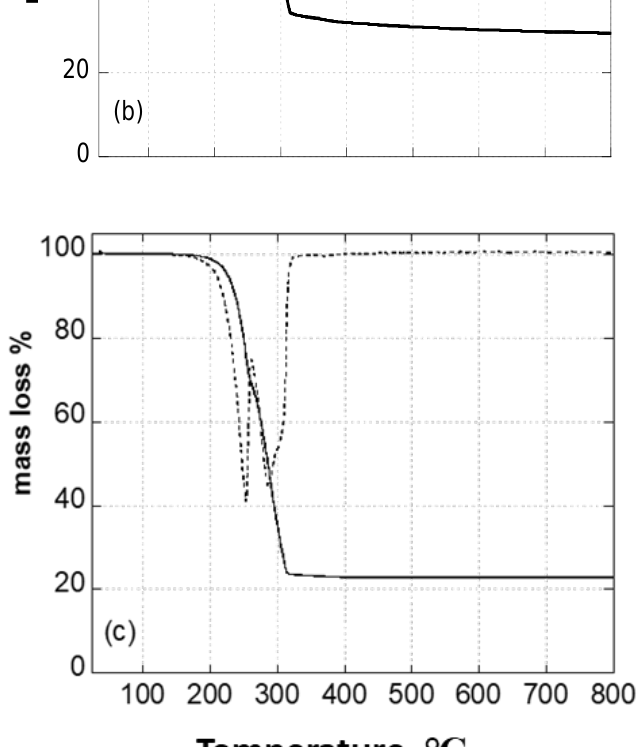
Figure 8. Thermogravimetric curves of [Zn(4,4′ -bipy) 2 (OAc) 2 ] ∞ samples prepared by the sonochemical process: ( a ) sample A; ( b ) sample B; ( c ) sample C.